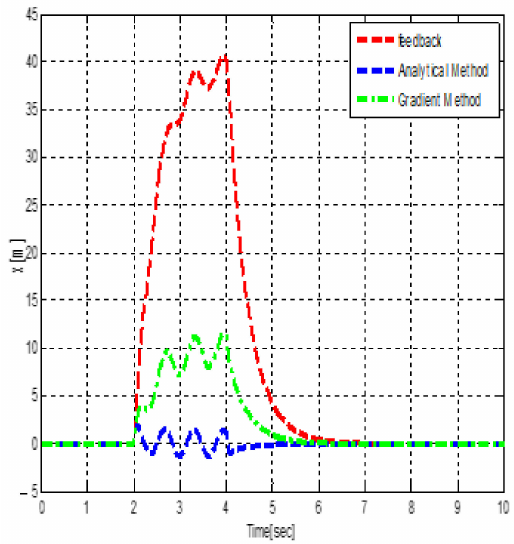
Figure 14. Drift facing turbulent